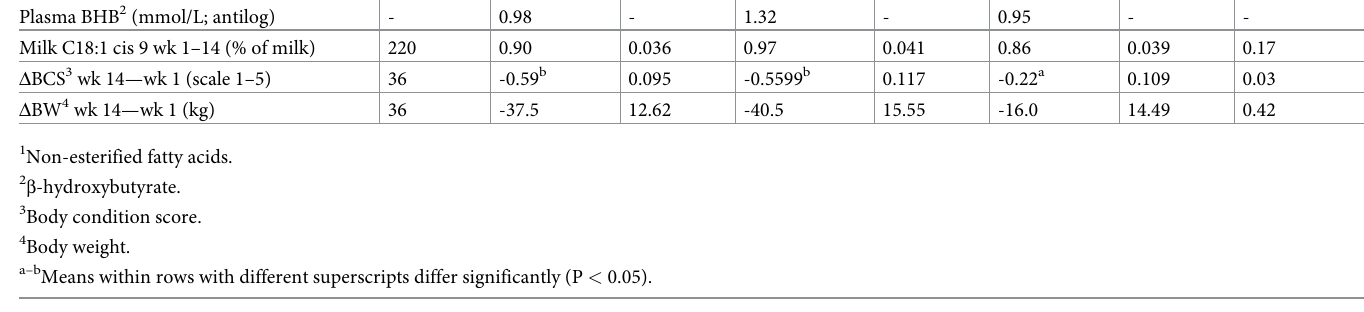
IRFI and HRFI while BCS were higher in HRFI cows than in LRFI NorFor NorFor NorFor NorFor cows. The HRFI cows had a positive weekly change in BCS during the 42-wk lactation NorFor period while it was negative for the other two RFI groups. The persistency of lactation NorFor was lower in HRFI than in IRFI and LRFI cows. Emissions of CH /day, CH / NorFor NorFor NorFor 4 4 DMI and of CH /ECM were all higher among HRFI cows than IRFI and LRFI 4 NorFor NorFor Nor- cows. For